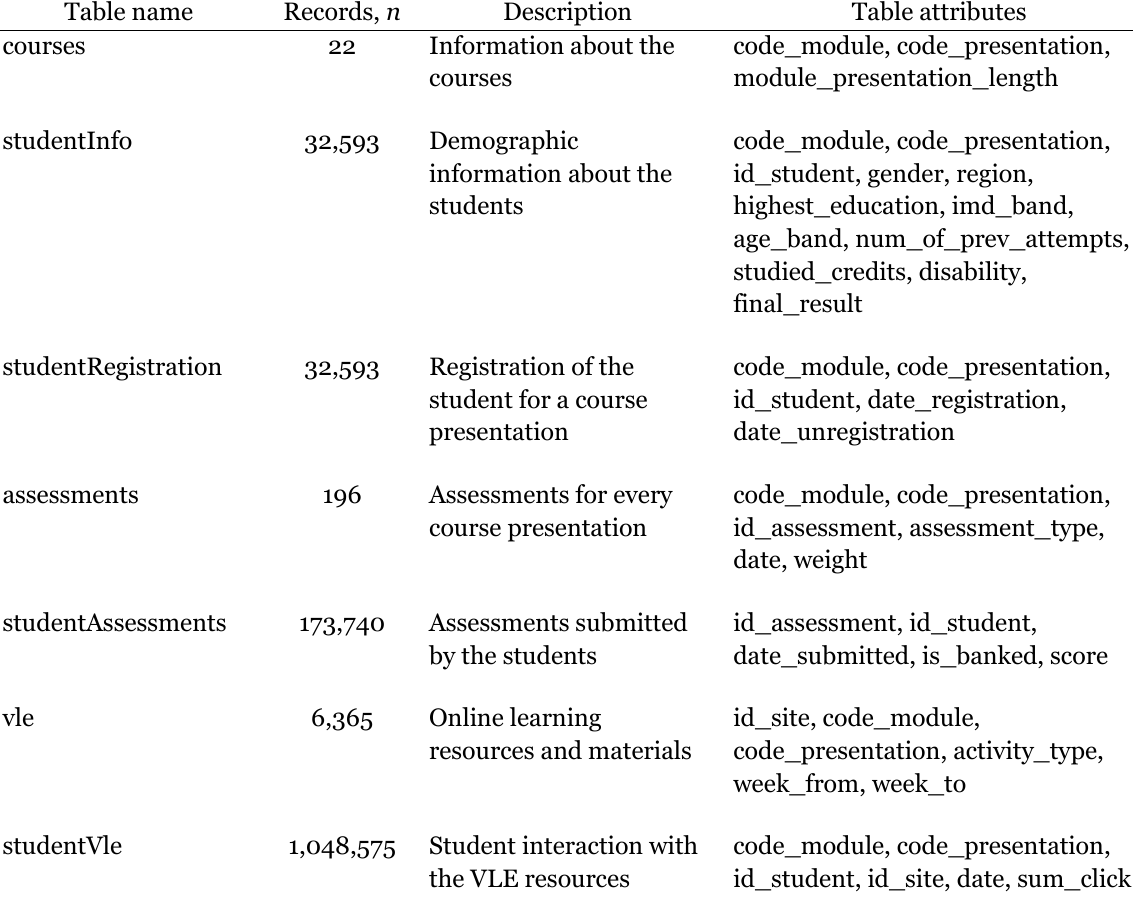
Summary of the Open University Learning Analytics